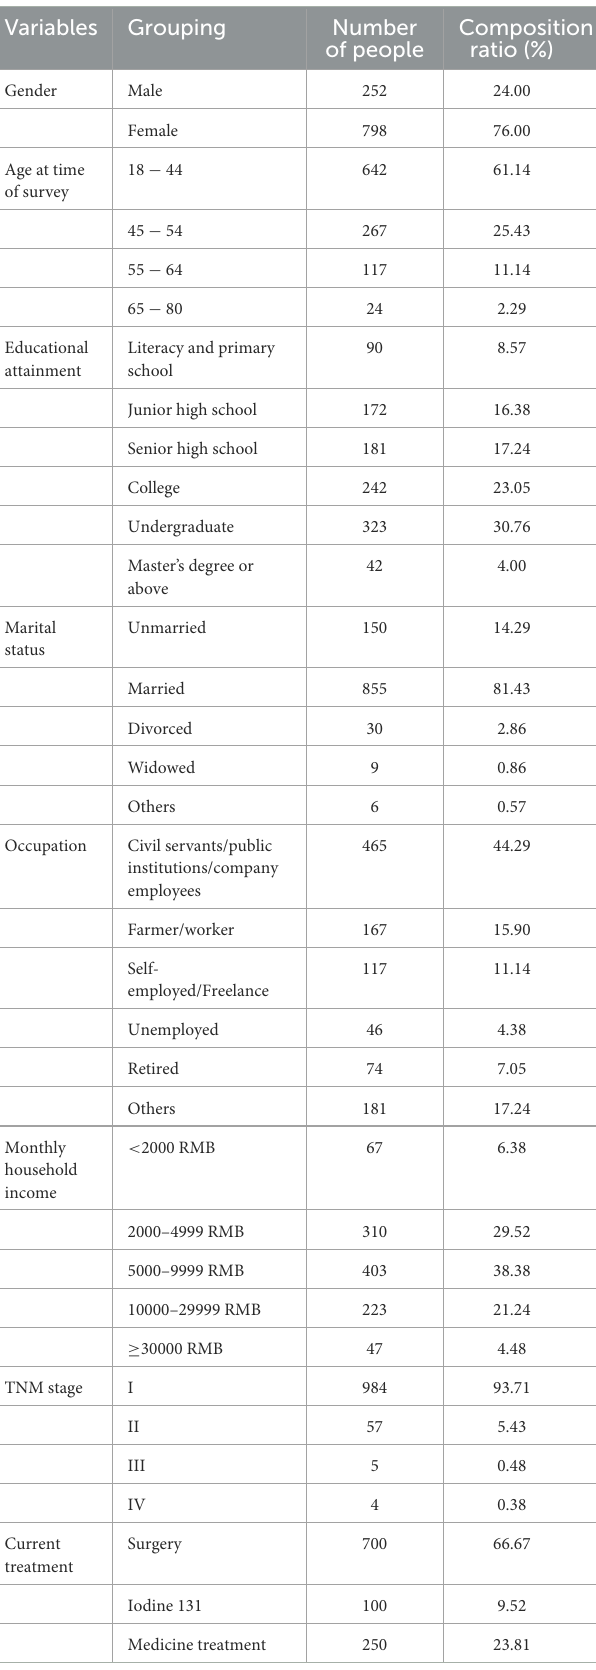
TABLE 1 Patient characteristics ( n =